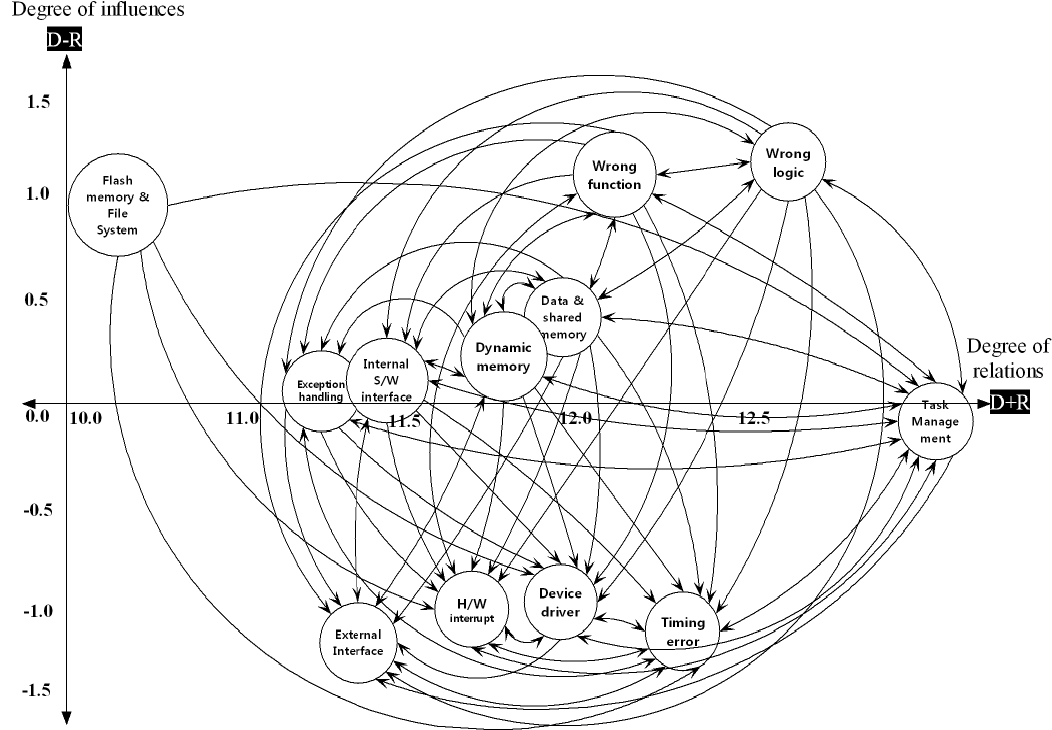
Figure 2. The impact relationship map of embedded software defects. Figure 3. The impact relationship map of embedded software